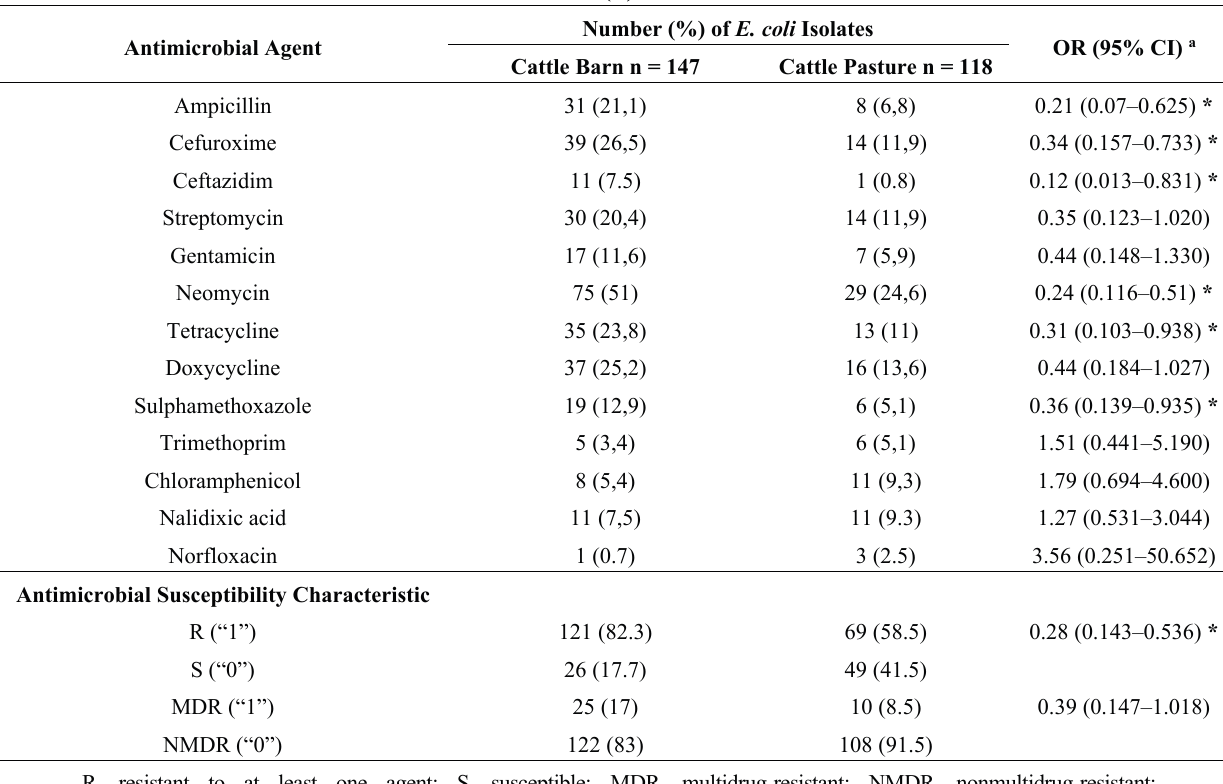
Table 2. Prevalence of resistance to 13 antimicrobial agents. ( A ) Among E. coli isolates from dairy and beef cattle; results from the mixed logit model; ( B ) Among animals with resistant E. coli ; results from the logistic model and tests of